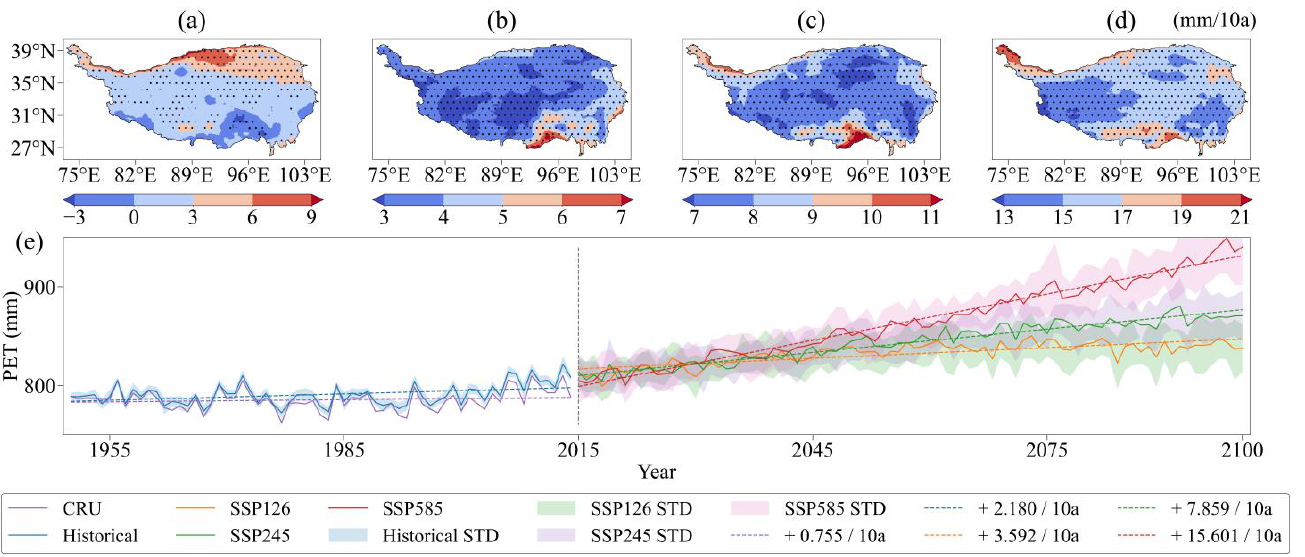
Figure 12. Trend test results of PET for the HQ-corrected ensemble model. ( a – d ) represent the spatial trend of precipitation in the historical and future scenarios, respectively. The black dots are significant points with p < 0.05. ( e ) represents the change curve of the precipitation of the ensemble model in the historical and future scenarios. The filling on both sides of the line represents the respective standard deviation, and the dashed line is the trend line.